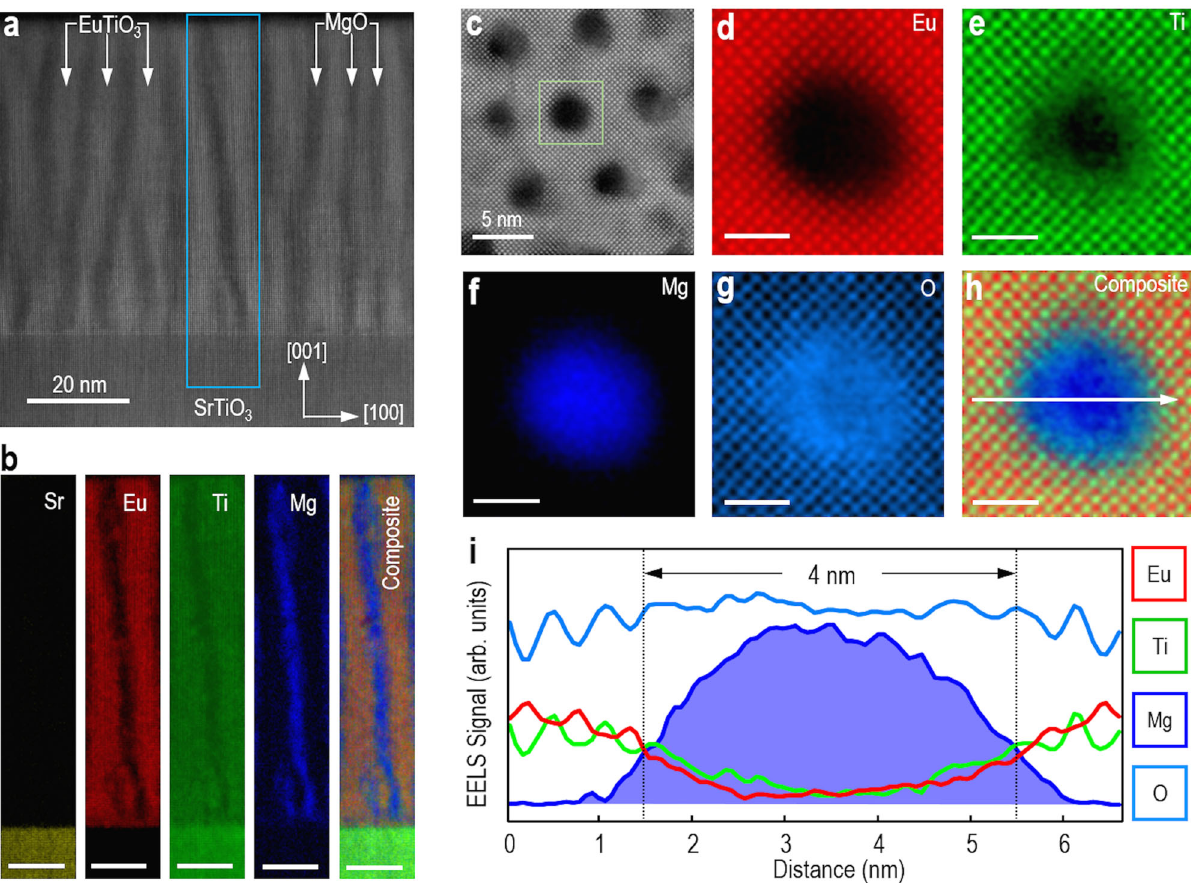
Fig. 1 STEM investigations of an ETO:MgO VAN fi lm. a Z-contrast HAADF-STEM image of the VAN fi lm in cross-sectional orientation, projected along the [010] zone axis. b Atomically resolved STEM-EELS elemental maps of a single nanopillar, corresponding to the rectangle region in ( a ). Scale bar: 10 nm. c HAADF-STEM image of the VAN fi lm in plan-view orientation, showing MgO nanopillars embedded in an ETO matrix. d – h Atomically resolved STEM- EELS elemental maps of a single nanopillar, corresponding to the rectangle region in ( c ). Scale bar: 2 nm. i EELS signal intensity pro fi les across the ETO/ MgO interfaces extracted along the white arrow direction in ( h